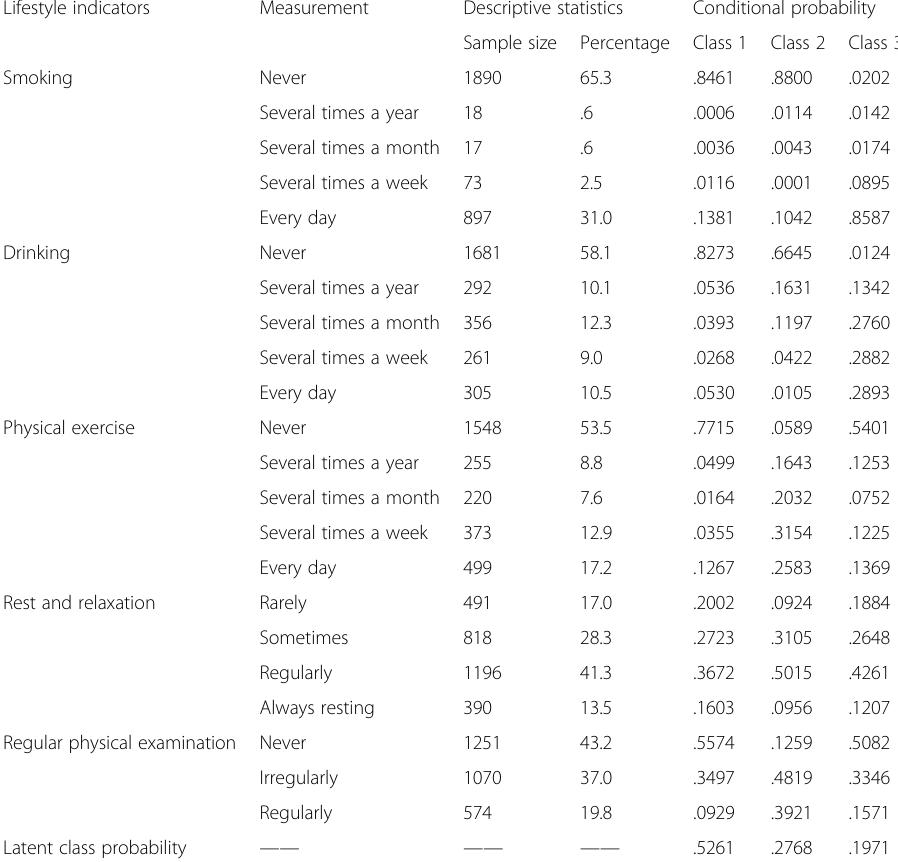
Table 2 Descriptive statistics of health behaviors and the probabilities and conditional probabilities of lifestyle latent classes, N = 3827 Lifestyle indicators Measurement Descriptive statistics